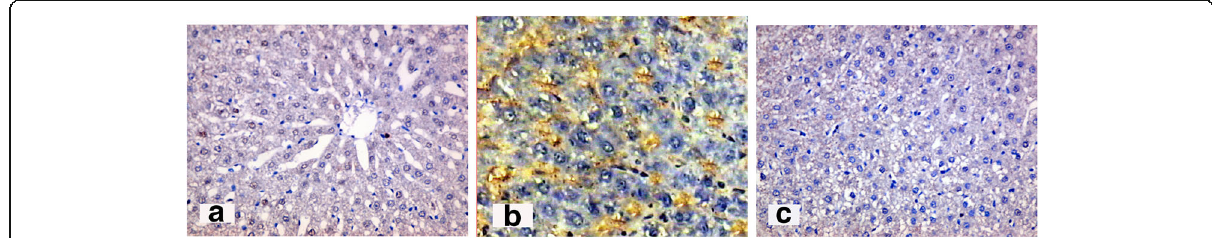
Table 1 Ameliorative effect of aged black garlic (ABG) on the migration of nuclear DNA in hepatocytes of the cyclophosphamide (CP)-treated rats Groups Parameters Tailed% Untailed% Tail length ( μ m) Tail DNA% Tail moment Control